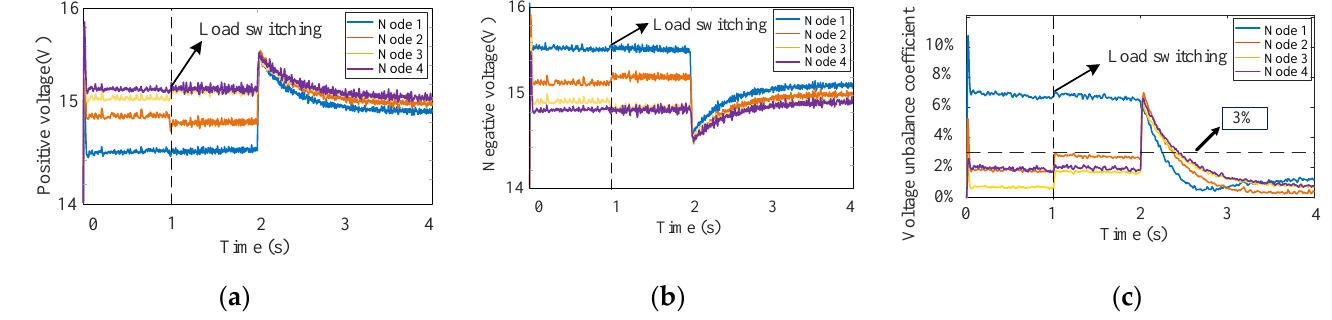
Figure 12. After the load switching, the influence of traditional droop control and consensus control on the multi-node bipolar DC distribution network’s ( a ) positive voltage, ( b ) negative voltage and ( c ) voltage unbalance coefficient.